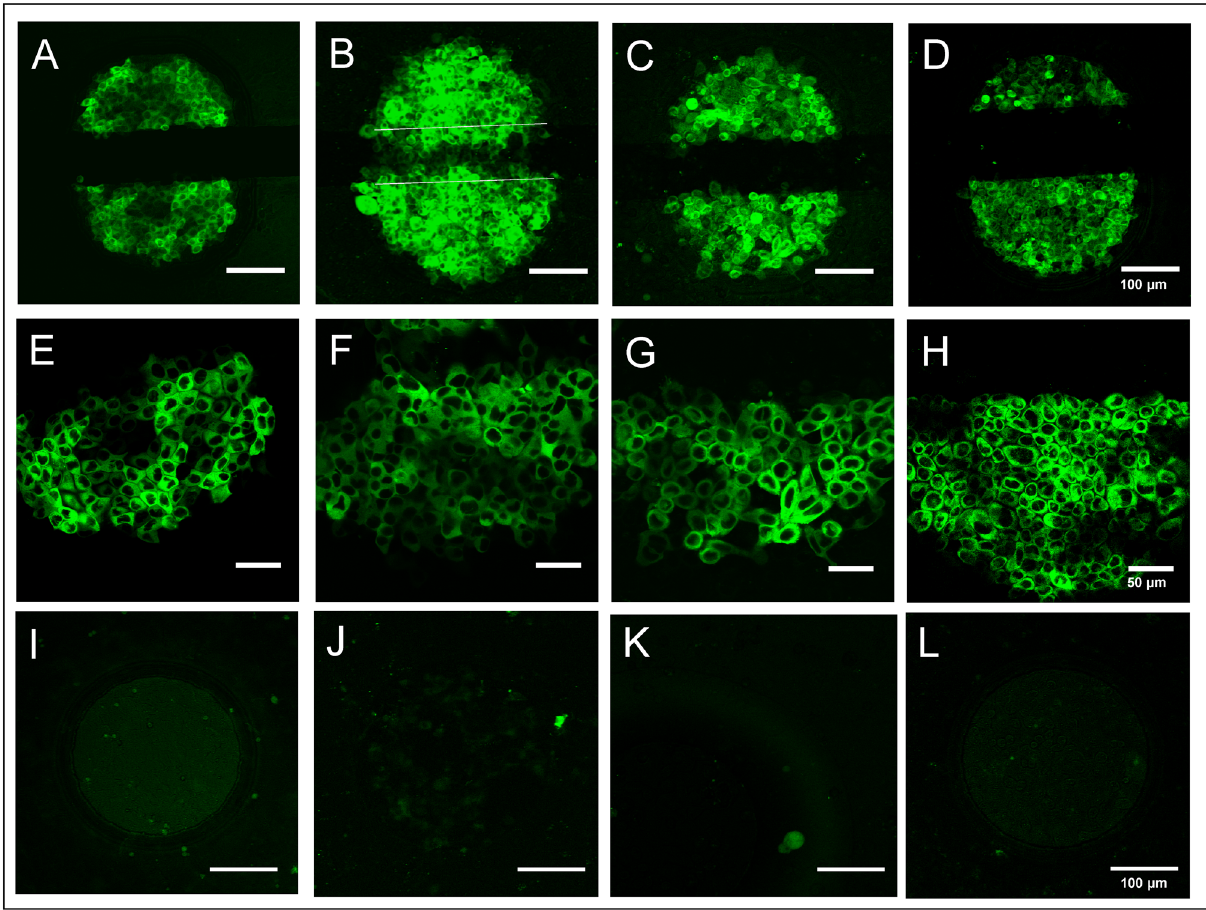
Figure 3. Confocal fluorescent micrographs of different adherent cell lines grown on micro-electrodes developed for µISE-ECIS after electroporation in the presence of 250 kDa FITC-dextran (2 mg/ml). ( A , E ) NRK; ( B , F ) HEK 293; ( C , G ) HEP-G2; ( D , H ) CHO. ( A – D ) Overview micrographs showing both cell- covered electrodes were taken with a 10× objective. ( E – H ) Magnified field of views from one half-circular microelectrode shown in A – D were taken with a 63× objective. I (NRK), J (HEK293), K (HEP-G2) and L (CHO) show monolayers of the different cell lines after incubation with the 250 kDa FITC-dextran (2 mg/ml) without any